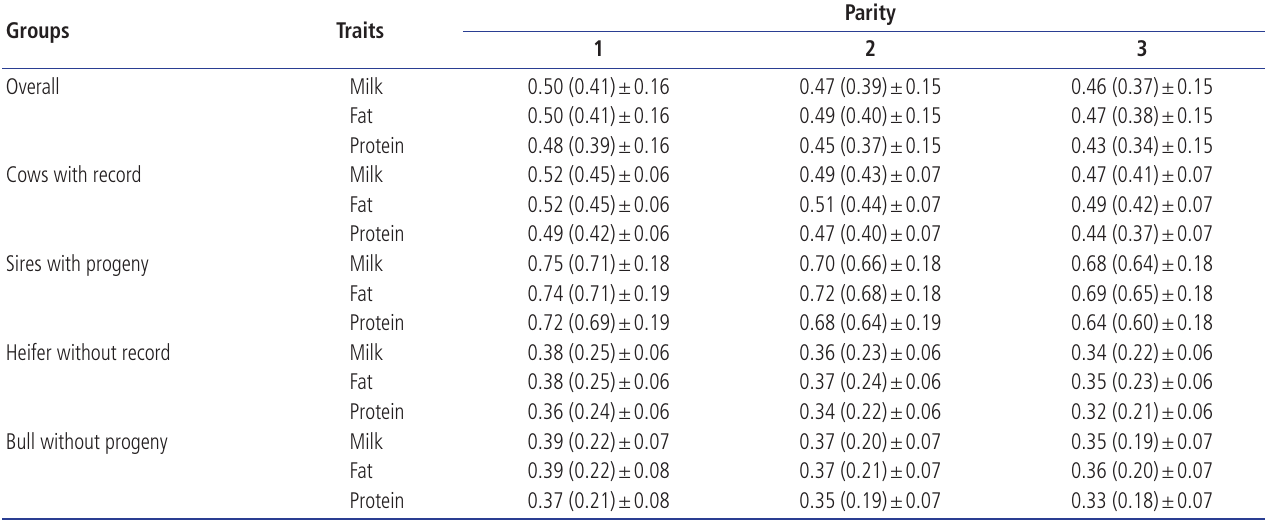
Table 3. Reliabilities on GEBVs (EBVs) and standard deviations of animals with SNP information for milk production traits (kg) in each group Groups Traits